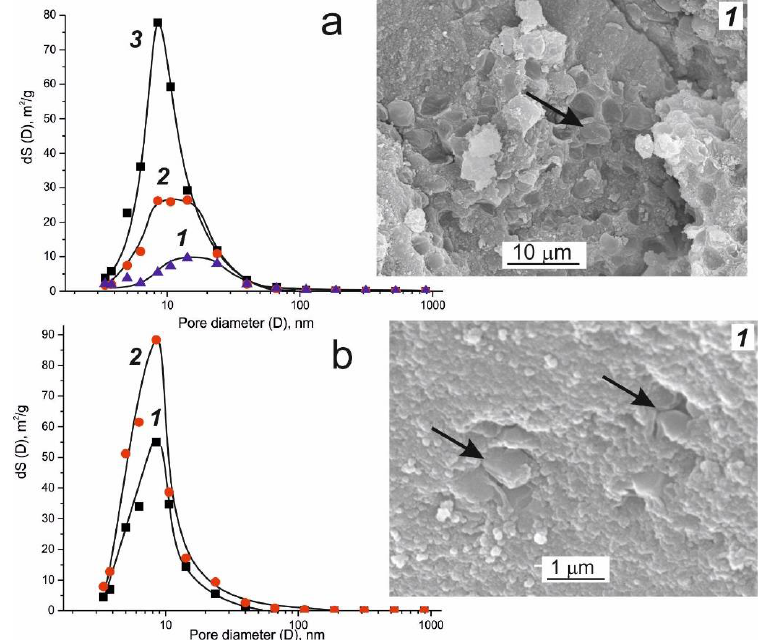
Figure 1. ( Left ) Pore size distributions: ( a ) entrapped S. cerevisiae biomass in contents of 20 w/w % ( 1 ), 60 w/w % ( 2 ) and 80 w/w % ( 3 ); ( b ) entrapped A. nicotianae ( 1 ) and r E. coli /xyl ( 2 ) biomass in content of 15 w/w % . ( Right ) SEM images of cleavages of the whole-cell biocatalysts. Arrows indicate microbial whole cells entrapped inside SiO 2 -xerogel.